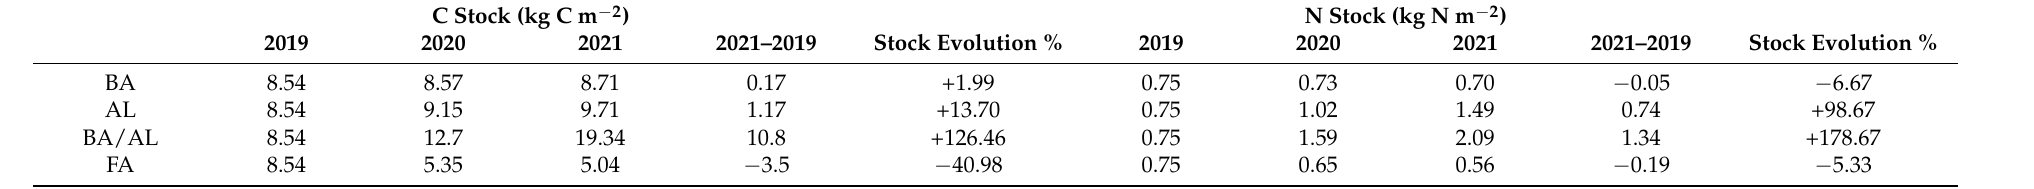
Table 5. Evolution of C and N stocks (0–60 cm) in the four sub-plots after two